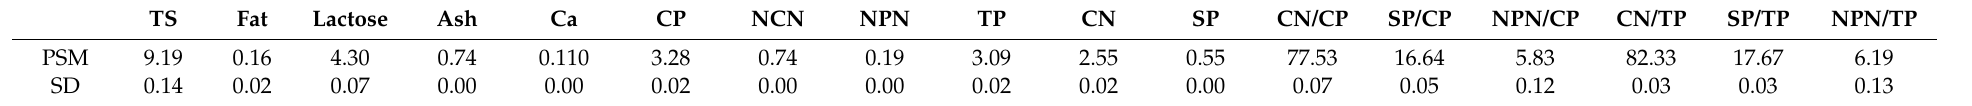
Table 1. Mean ( n = 3) composition (% by weight) of pasteurized skim milk used in each replicate during microfiltration and ultrafiltration polymeric spiral-wound membranes. TS Fat Lactose Ash Ca CP NCN NPN TP CN SP CN/CP SP/CP NPN/CP CN/TP SP/TP NPN/TP PSM 9.19 0.16 4.30 0.74 0.110 SD 0.14 0.02 0.07 0.00 0.00 0.02